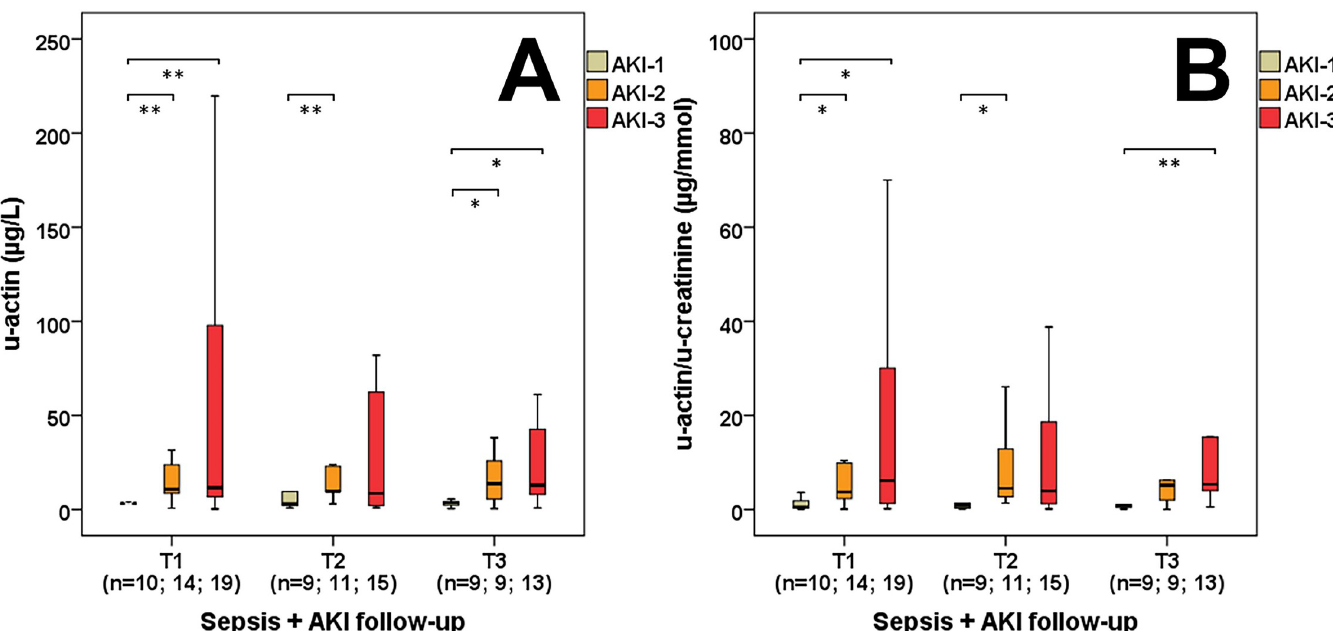
Fig 2. Urinary actin in sepsis-related AKI. U-actin (A) and u-actin/u-creatinine (B) levels of the individual sepsis-related AKI stages during follow-up. n: sample count. � p < 0.05; �� p < 0.01.